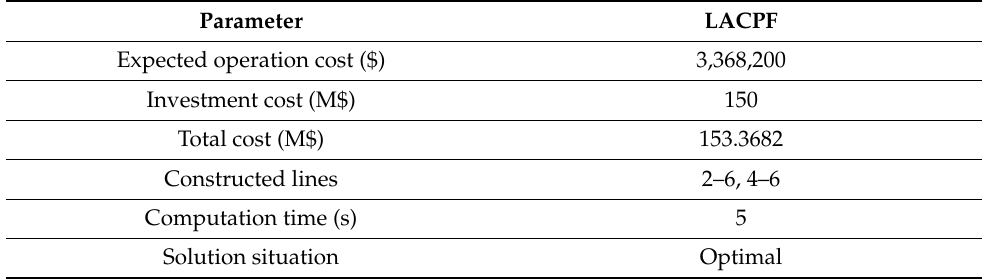
Table 6. Results of different factors in 6-bus network for